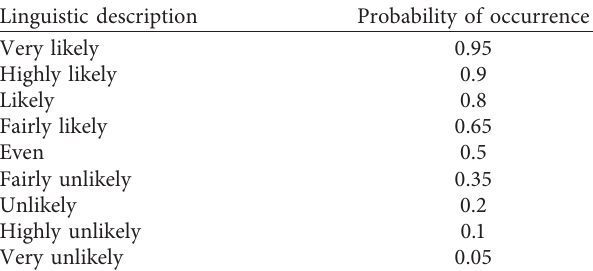
Figure 1: Bayesian network for overtopping risk analysis of earth dams considering failure duration of release structures. Table 1: Probabilities corresponding to linguistic description of likelihood.